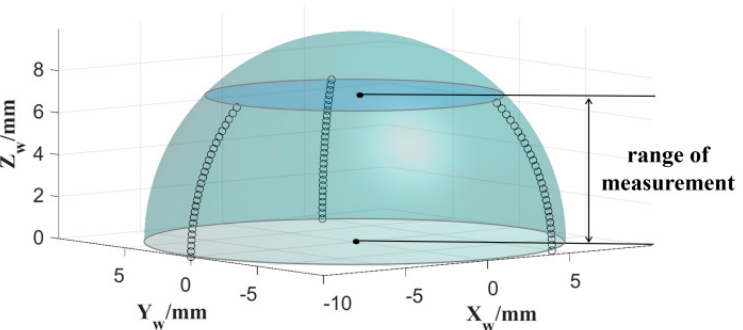
Figure 9. Measurement track of the hemisphere.